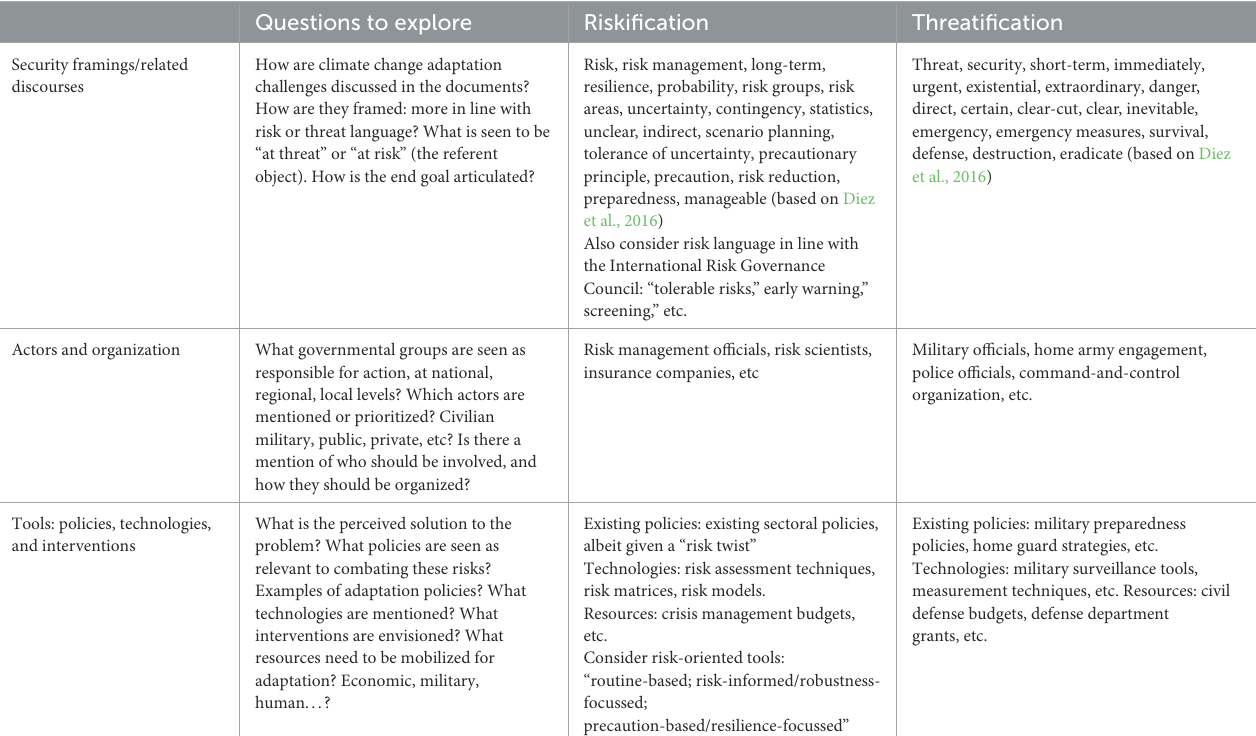
TABLE 1 Analytical Framework (adopted from Rhinard et al.,